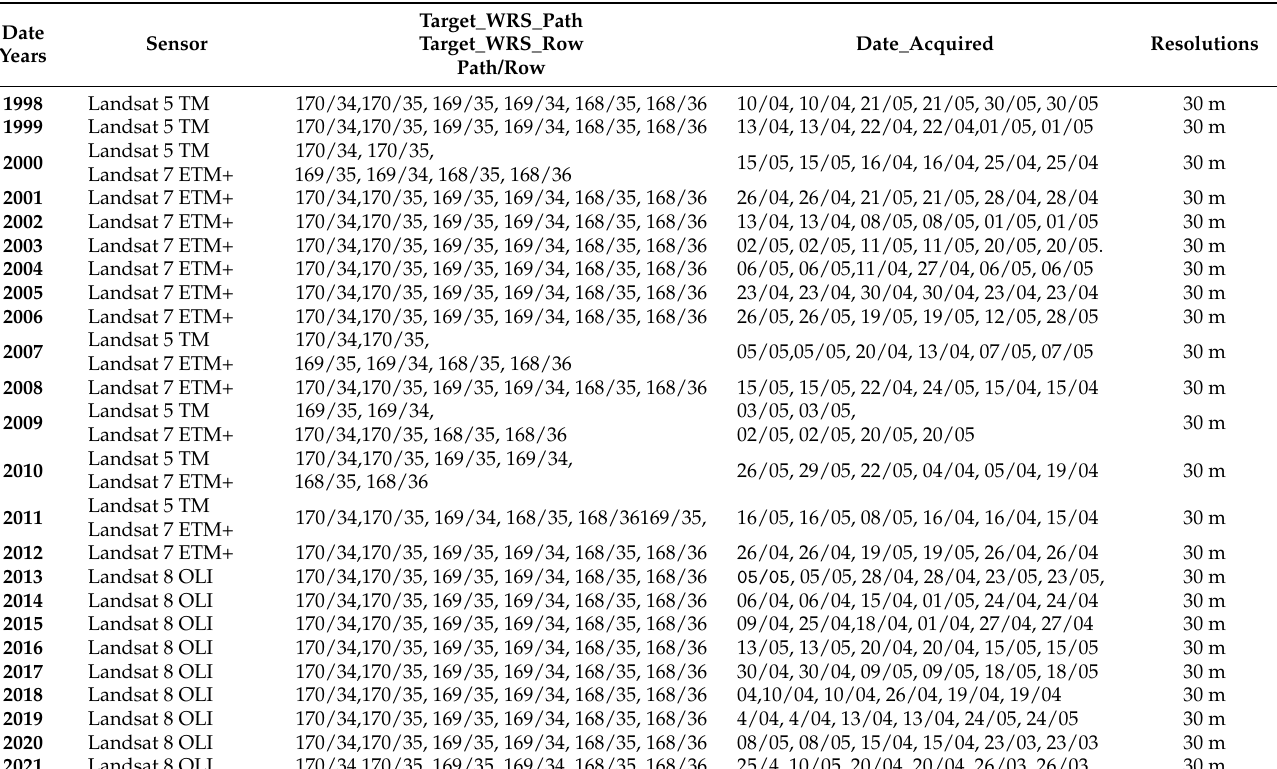
Table A2. Landsat data chosen for analysis were a mixture of Landsat TM5, ETM7, and Landsat